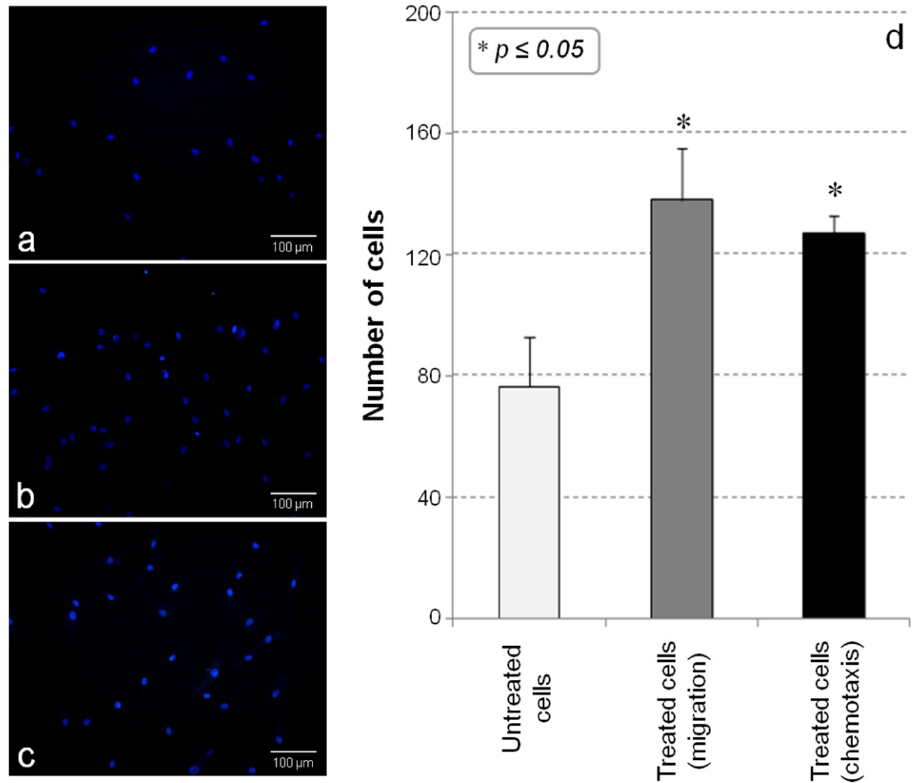
Figure 2. Cell migration assay. Optical microscopy of Ad-MSCs migrated through the porous filter after 24 h of incubation: ( a ) untreated cells vs. cultures treated with differentiation medium for ( b ) migration or ( c ) chemotaxis evaluation (Scale bar: 100 µm). ( d ) Effects on cell migration and chemotaxis of endothelial growth factors. The results are reported as mean of three different experiments ± standard deviation. (* p < 0.05).